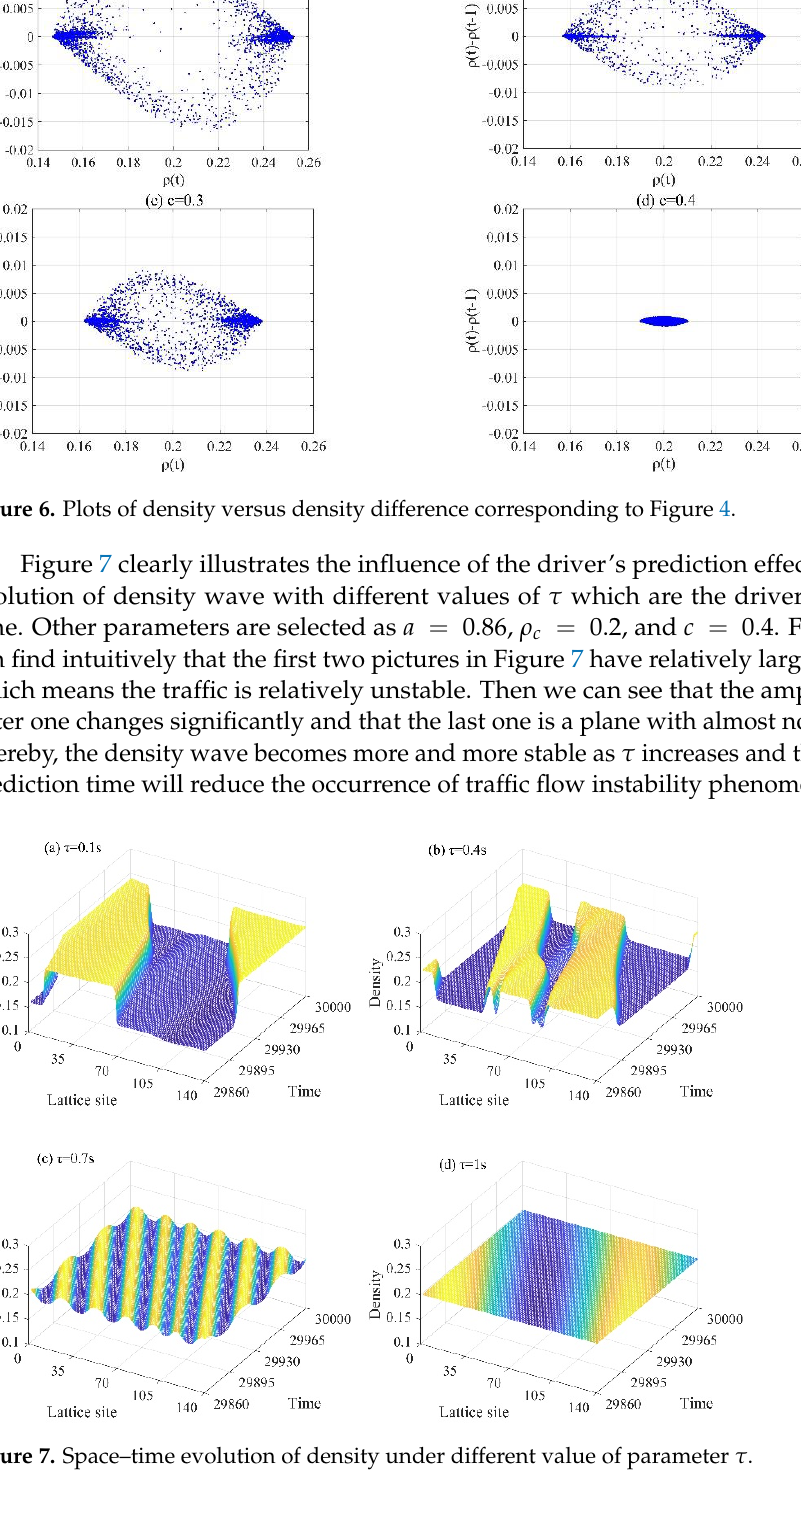
Figure 5. Density profile at 10300 t s = corresponding to Figure 4.